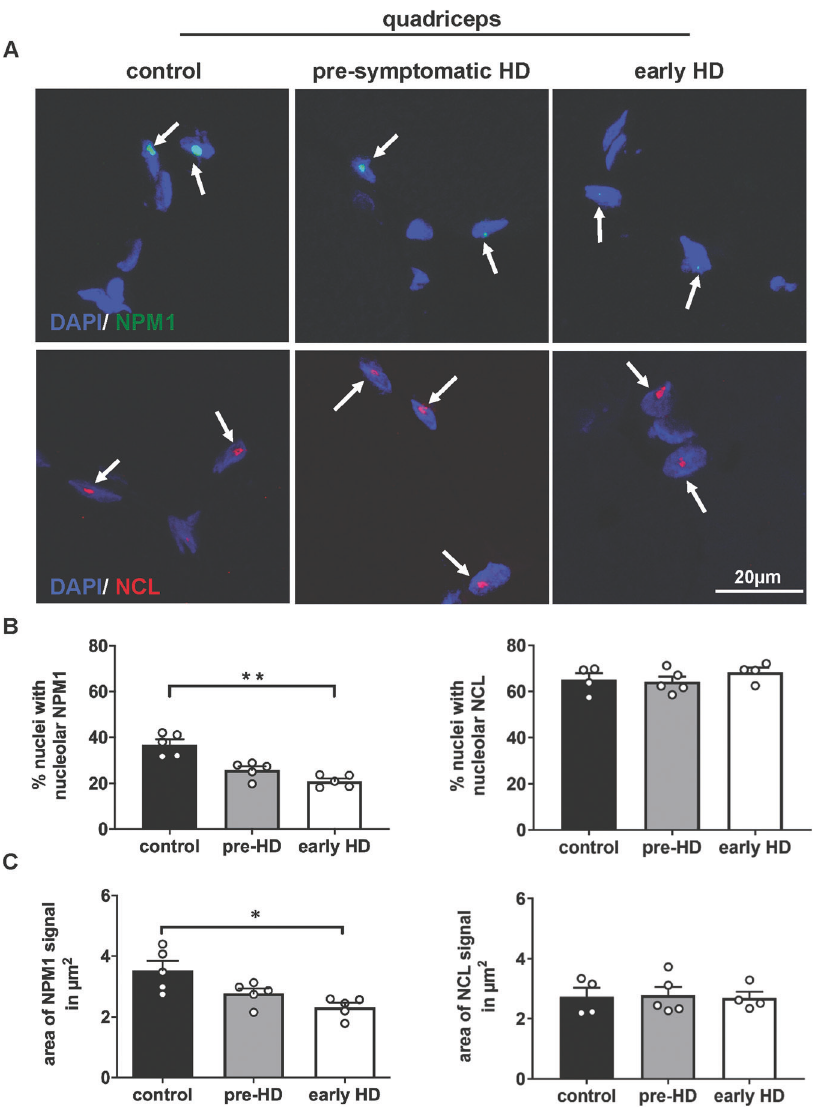
Fig. 6 NPM1 signal is reduced in muscle (quadriceps) biopsies of early-Huntington ’ s disease patients. A Representative confocal images of human skeletal muscle (quadriceps) cryosections immunostained for NPM1 (green) or NCL (red) in HD patients at different stages and in age- matched controls. Nuclei are labeled with DAPI (blue). The arrows point to NPM1 or NCL signals. Scale bar: 20 μ m. B Quanti fi cation of the percentage of nuclei showing nucleolar NPM1 signal in HD patients in comparison with age-matched controls (N = 5 for each group), and indicating signi fi cant decreased NPM1 in early-HD by Kruskal – Wallis test and Dunn ’ s multiple comparison ( p = 0.003 early-HD vs. controls). No signi fi cant differences in the percentage of nuclei with nucleolar NCL. C Mean area of the NPM1 signal (in μ m 2 ) per DAPI positive nuclei in control, pre- and early-HD individuals (N = 5 for each group). Statistically signi fi cant decrease of NPM1 signal area in early-HD compared with controls by Kruskal – Wallis test and Dunn ’ s multiple comparison ( p = 0.01). No signi fi cant differences in the mean area of the NCL signal (in µm 2 ) between the different groups. Error bars represent SEM. * p < 0.05, ** p < 0.01; detailed statistical information is included in the Supplementary Statistical Information fi patients and control individuals. More precisely, we investigated the NPM1 and NCL fl uorescence-signal patterns in quadriceps from biopsies of nonaffected controls, presymptomatic, and early- symptomatic HD patients, similar as in the zQ175 mice. (Fig. 6A – C and Table S1). In early HD patients, the percentage of DAPI positive nuclei showing nucleolar NPM1, and also the area of the NPM1 signal were about 2- and 1.5-fold lower than those of controls, respectively (Fig. 6B, C). In the pre-HD cohort, we observed a nonsigni fi cant trend for reduced signals. A similar analysis performed for NCL showed no differences in these parameters at any stage (Fig. 6B, C). Nuclear areas were similar in all groups (Fig. S7C).